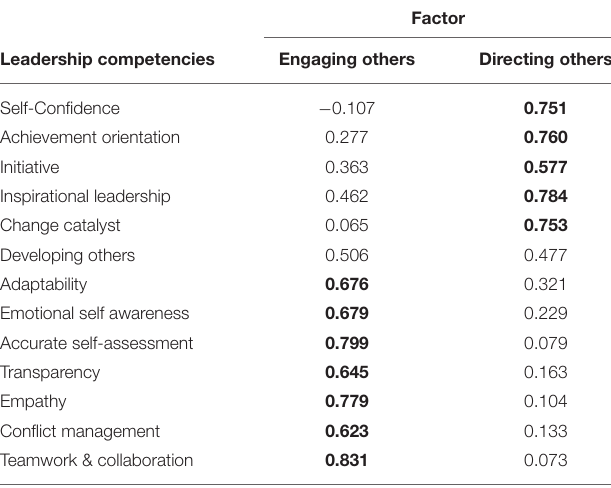
TABLE 1 | Exploratory factor analysis for the leadership competencies scale–rotated factor